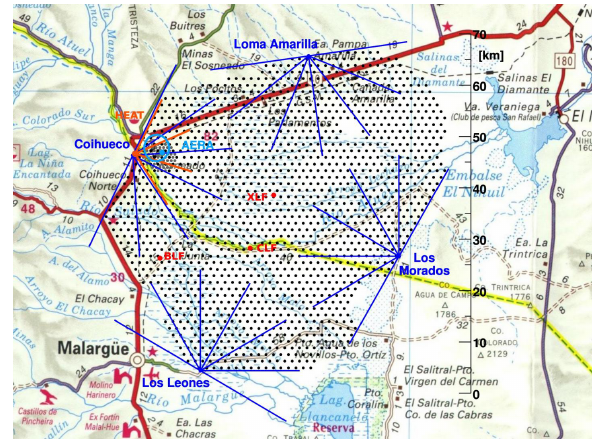
Figure 1. The Auger Observatory [1]. Each dot corresponds to one of the 1661 Surface Detector stations. The four fluorescence detector sites are illustrated, each with the 30 ◦ field of view of its six telescopes. Also shown are the two laser facilities, CLF and XLF, near the center of the Observatory. In front of the Coihueco fluorescence detector is the location of the dense array, where Surface Detectors are installed on a 750 m grid and the location of the Auger Engineering Radio Array